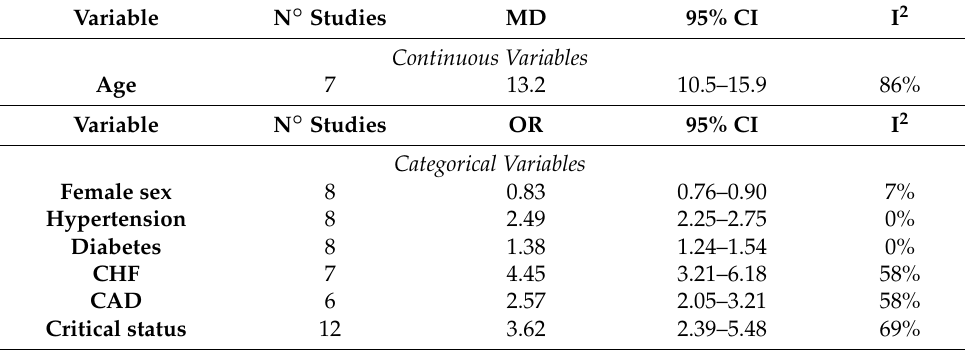
Table 3. Association of clinical characteristics with AF.